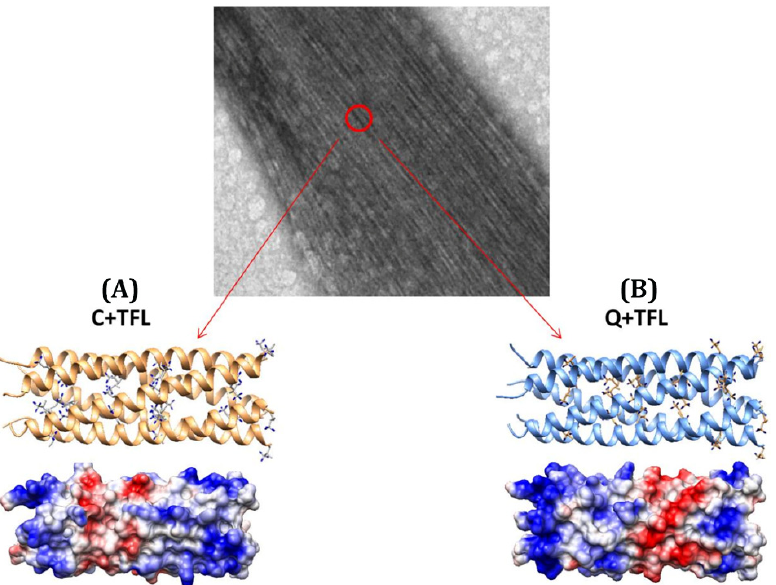
Figure 8. TEM image of a representative coiled-coil fiber formed by ( A ) C+TFL and ( B ) Q+TFL. Ribbon diagrams displaying the spread of TFL side chains are depicted alongside their electrostatic surface profiles where red represents negatively charged regions and blue represents positively charged regions. Reprinted with permission from [56]. Copyright 2015 American Chemical